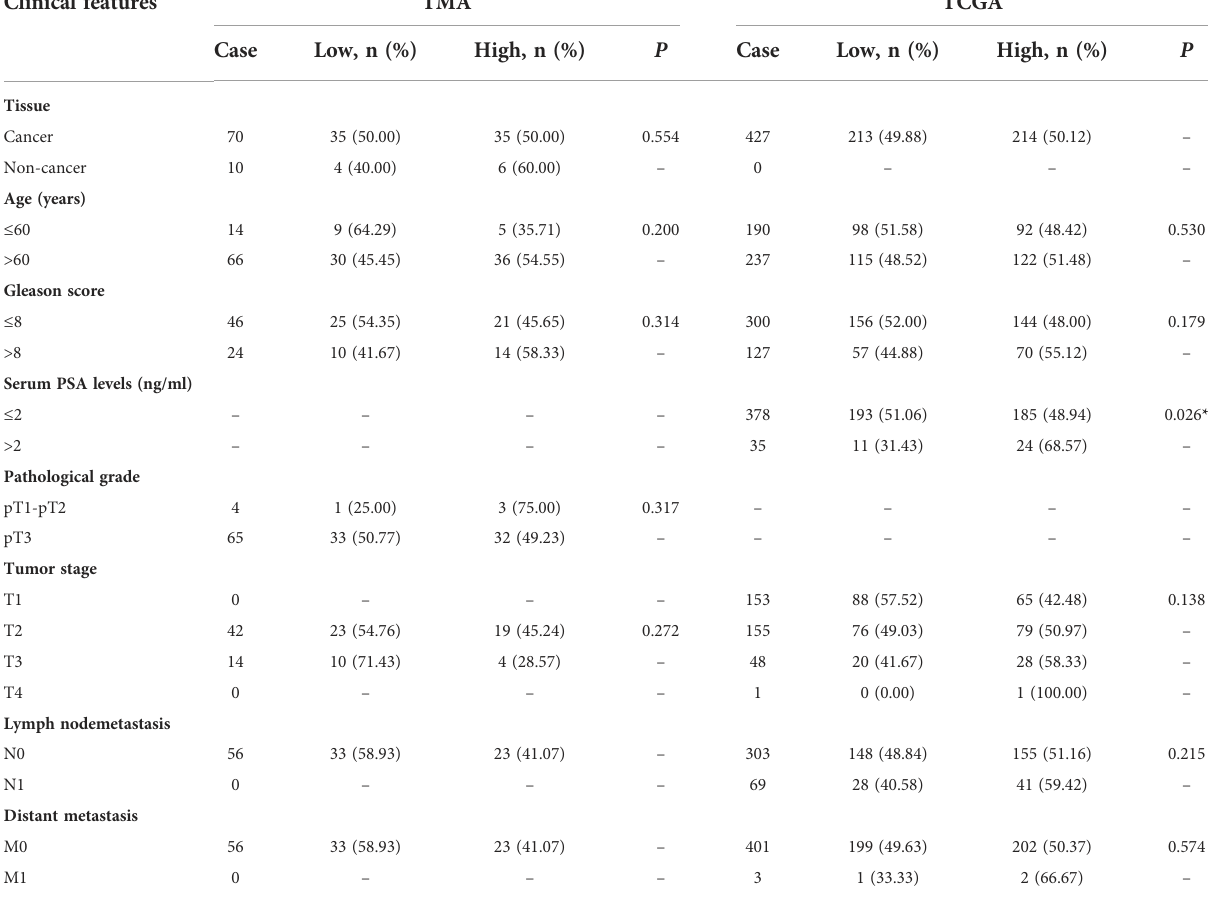
＊ means the difference is signi fi cant at the 0.05